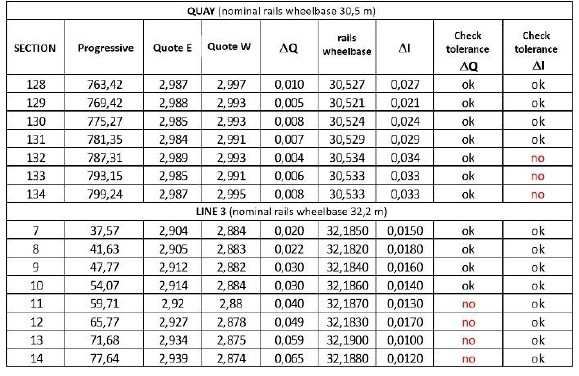
Figure 13. Testing the parallelism and of the level difference of the rails